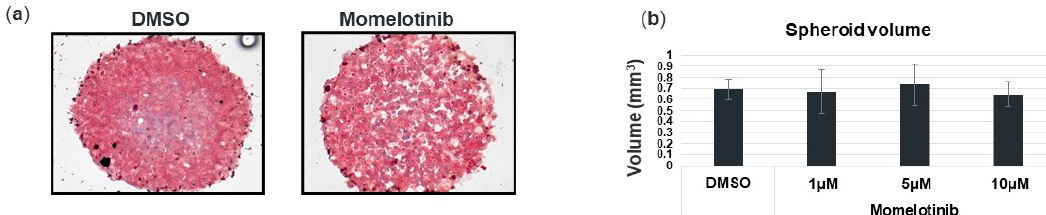
Figure A1. Spheroid volume was not a ff ected by momelotinib treatment. ( a ) ORO stain of representative